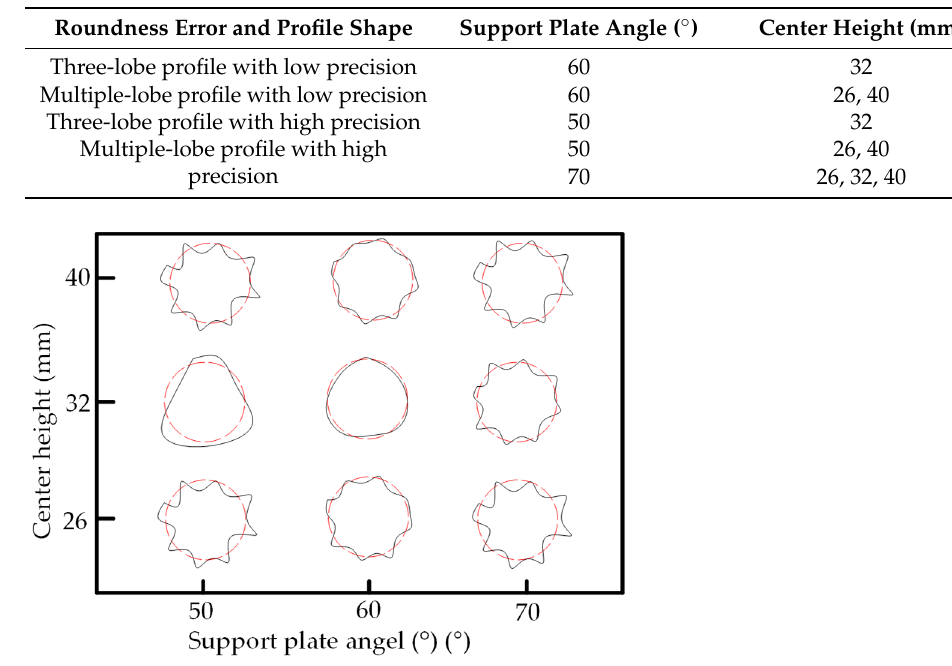
Table 6. Roundness error and profile shape under different processing parameter combinations.